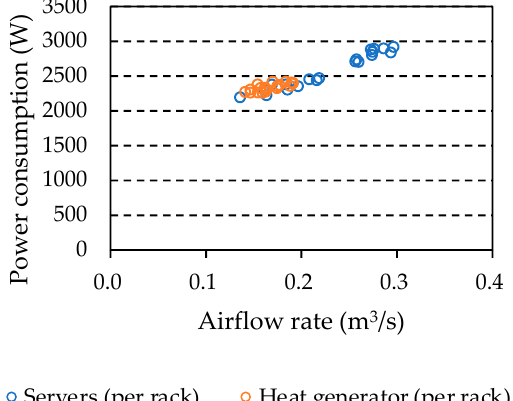
Figure 10. Relationship between equipment airflow rate and power consumption per rack (“server” represents result of experiment B; “heat generator” represents results of experiments C and D).